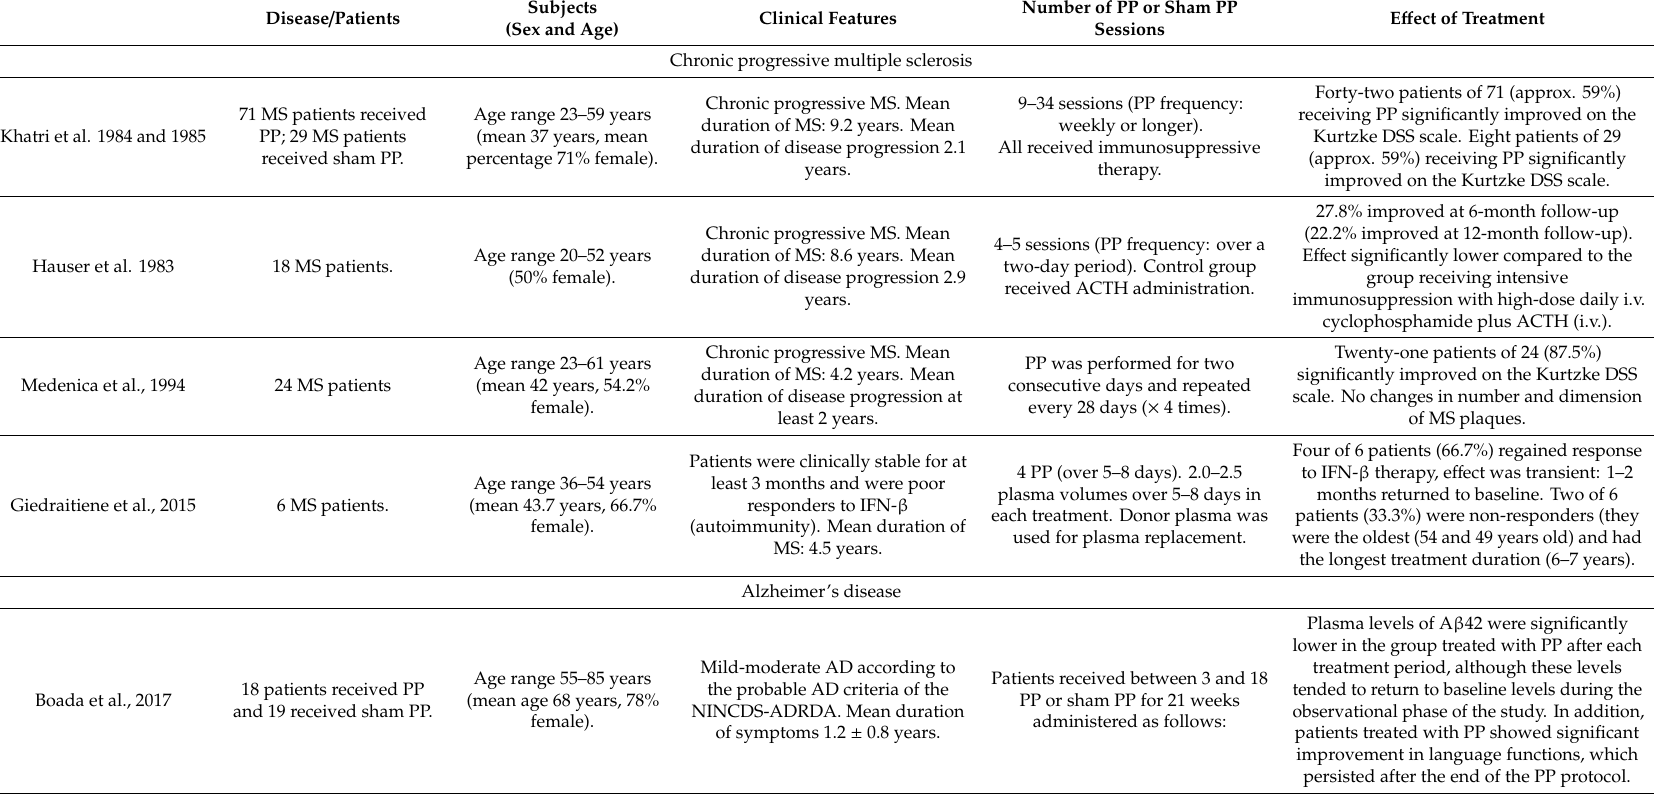
Table 1. Main characteristics of clinical studies